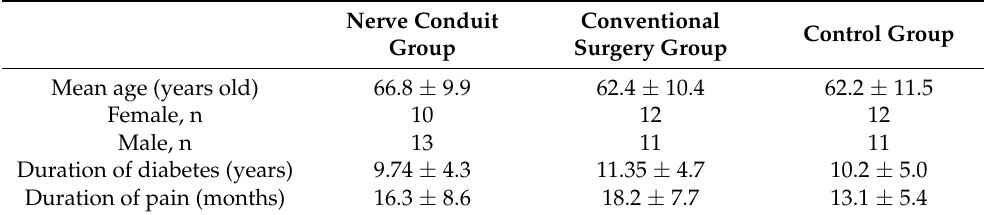
Figure 1. Illustration of the nerve conduit and incisions. ( A ) Photograph of the nerve conduit. ( B ) Photograph of the third surgical incision. ( C ) Photograph of the fi rst surgical incision. ( D ) Photo- Table 1. Demographic and clinical features of patients in different groups. graph of the second surgical incision. Table 1. Demographic and clinical features of patients in di ff erent groups.